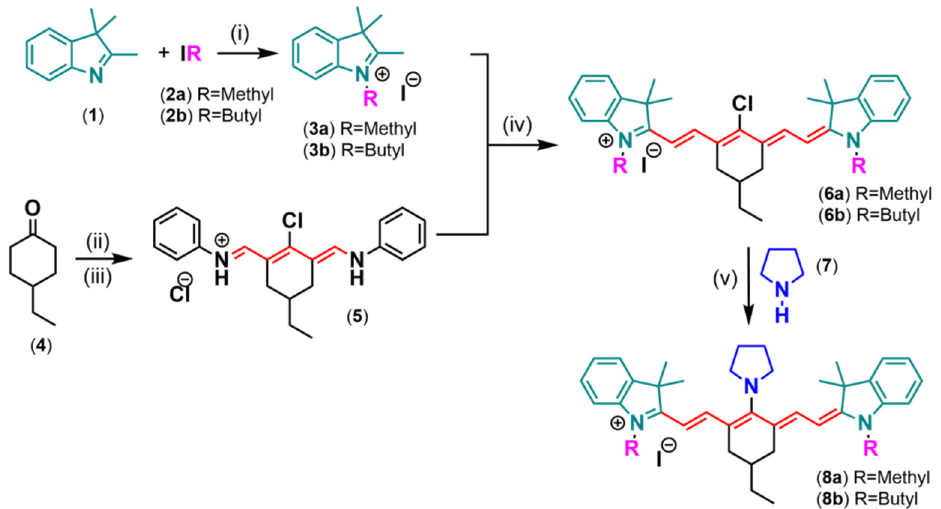
Table 1. Photophysical data of heptamethine cyanine dyes 6a-b in solution, where λ abs and λ em are the absorption and emission maxima (nm), respectively; ε is the molar extinction coefficient (M − 1 · cm − 1